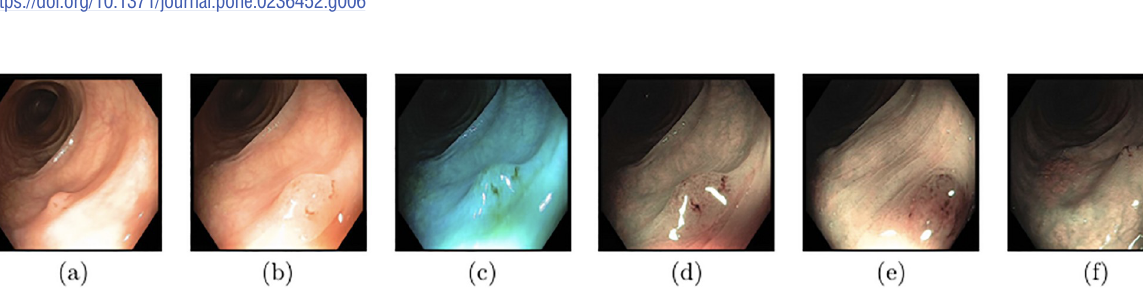
Fig 7. Images from different viewpoints: Six sample frames from the same sequence. The same polyp looks considerably different due to the variations of viewpoints and lighting conditions.